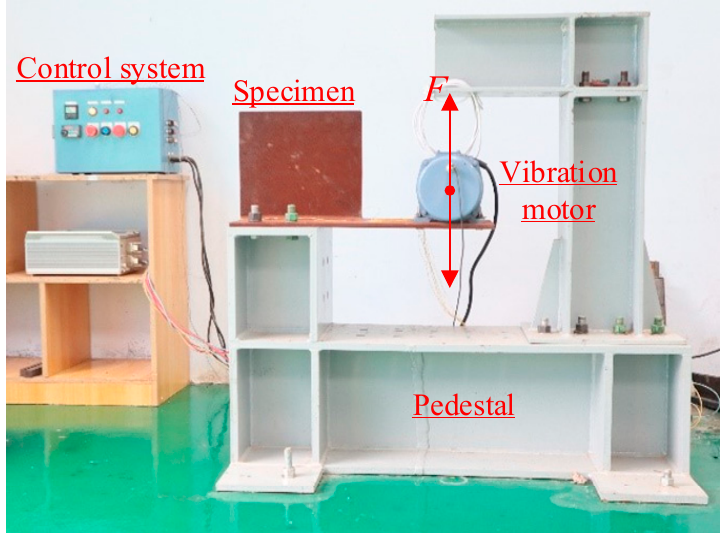
Figure 3. Test setup.